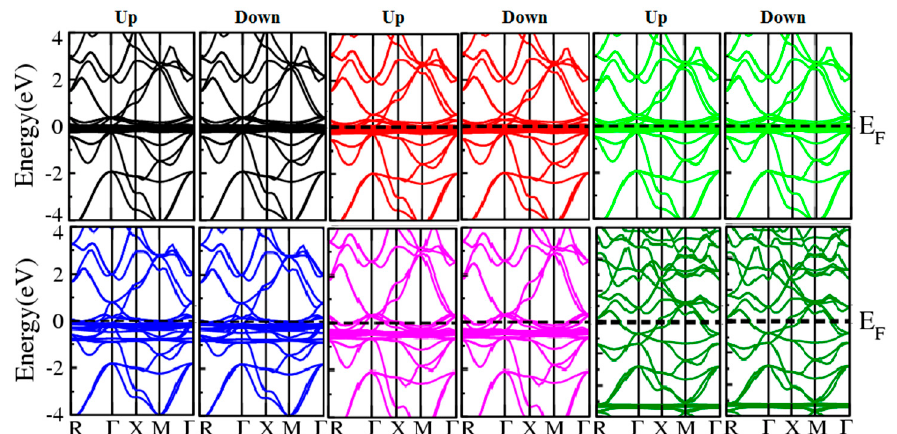
Figure 6. Electronic band structure of the rare earth nitrides Ln 3 NIn (Ln = Dy-Lu) anti-Perovskite. Black, red, green, blue, magneta and dark green colors indicate the band structure for Dy 3 NIn, Ho 3 NIn, Er 3 NIn, Tm 3 NIn, Yb 3 NIn and Lu 3 NIn.